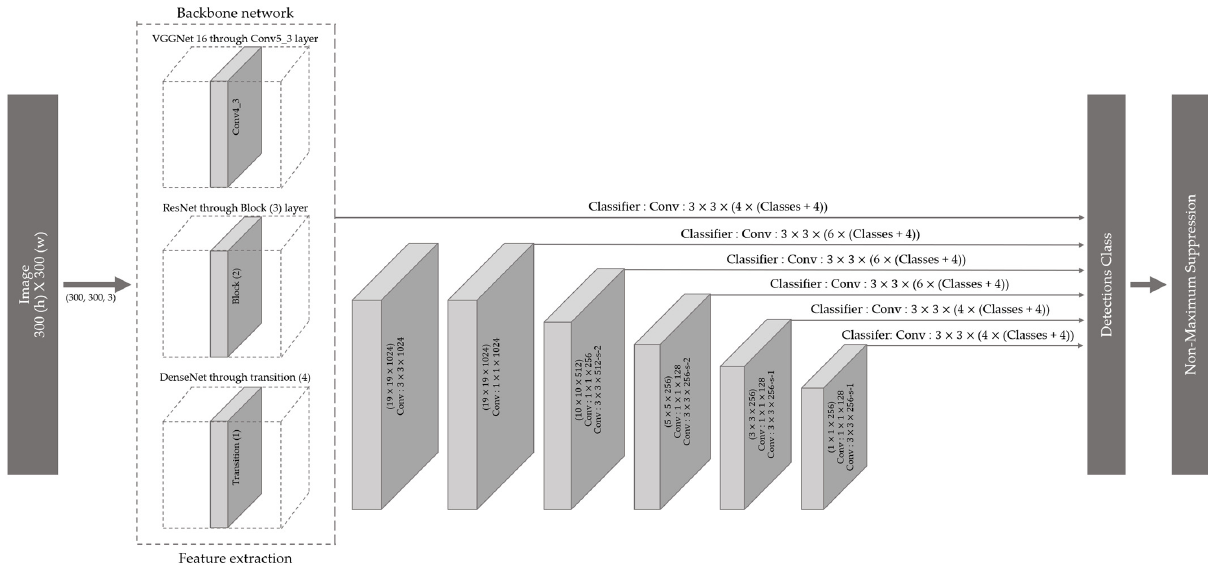
Figure 2. Single Shot MultiBox Detector model architecture with different convolution neural network (CNN) backbone networks for the classification of the 26 Amazon parrot species.